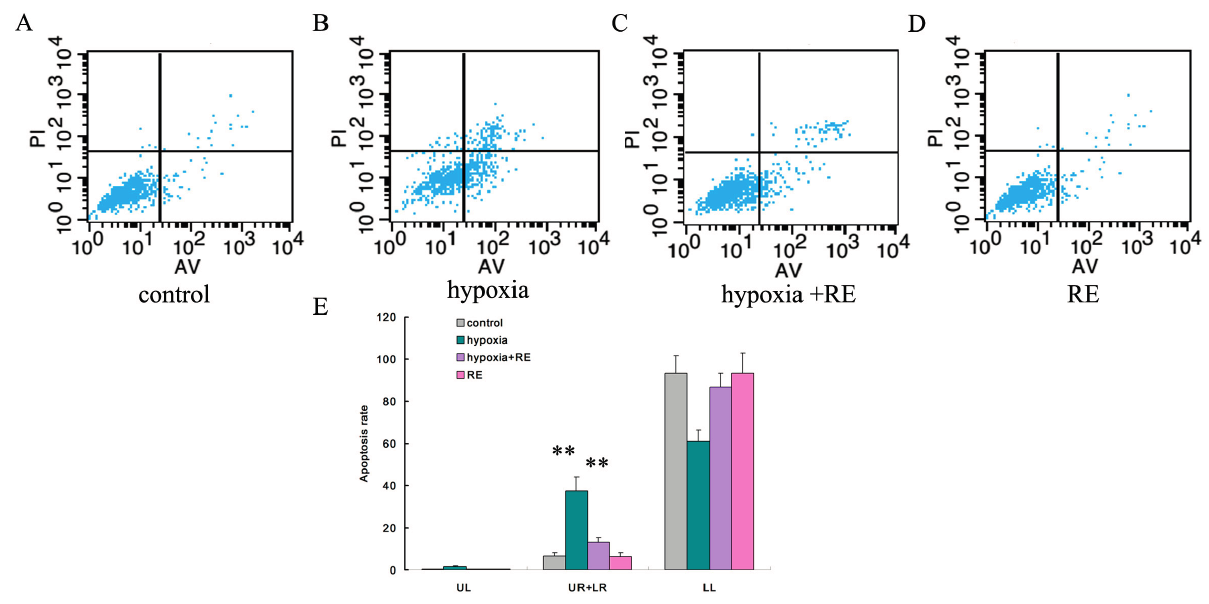
Figure 3. Rescue role of resveratrol in apoptosis of trophoblasts induced by hypoxia as detected by flow cytometry. ( A ) Apoptosis results of HTR-8/SVneo cells without any treatment (control). ( B ) Apoptosis of HTR-8/SVneo cells cultured in hypoxic conditions for 24 h showed a significant increase as compared with the control group. ( C ) Apoptosis of HTR-8/SVneo cells treated under hypoxic conditions and resveratrol revealed reversal of apoptosis compared with hypoxia-only treatment. ( D ) Cells treated with resveratrol alone displayed a similar level of apoptosis as those of control cells. ( E ) Statistical analyses of the flow cytometric data shown above (** p <